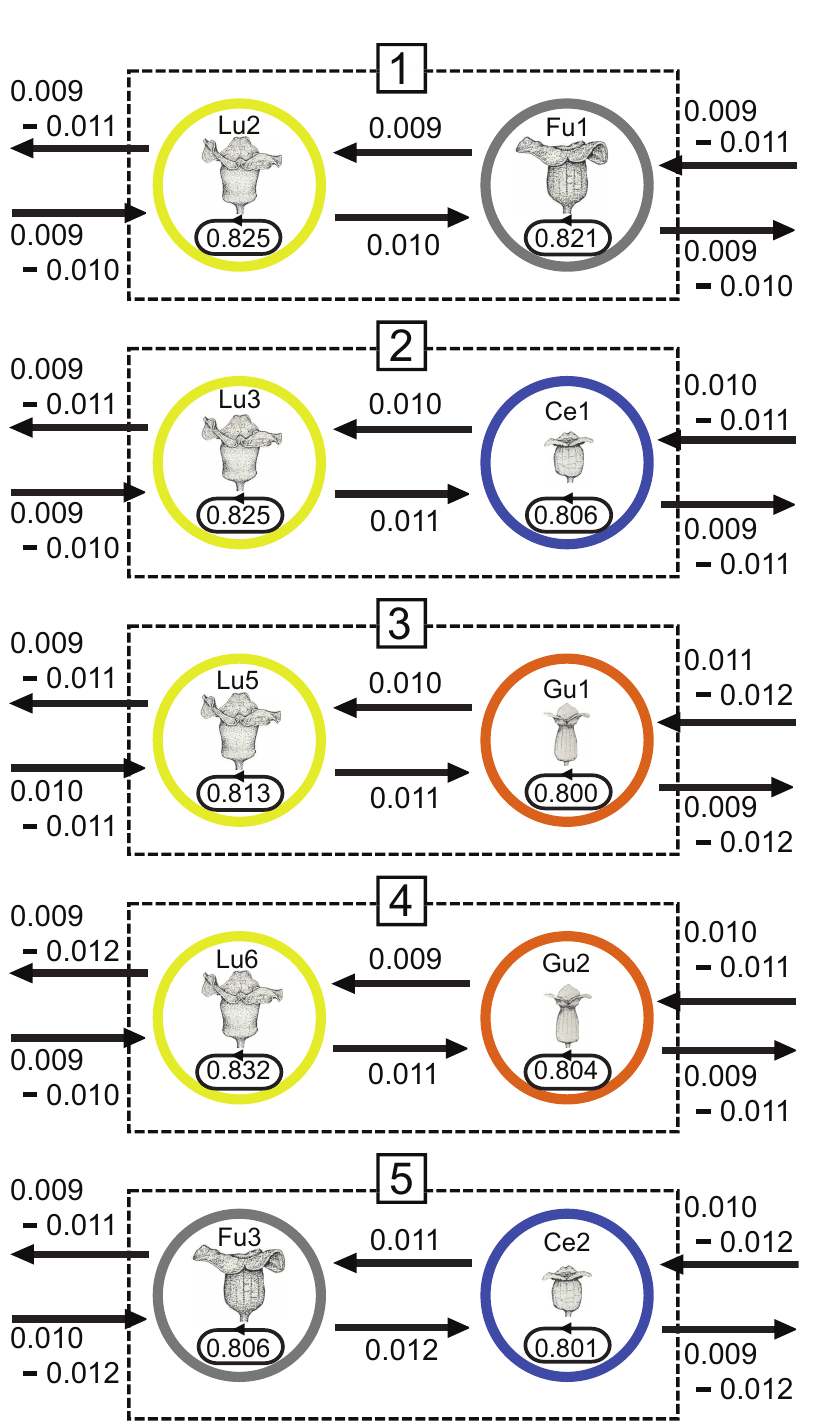
Fig 6. Mean values for the posterior distribution of the migration rate ( m ) of each Asarum populations within “sympatricstands” on Amami Oshima estimated using BayesAss. Estimated migrationrates are shown betweenspecies in “sympatric stands” 1–5, each of which containstwo species. The estimates for “sympatric stands” 1 – 4 were based on data for the nine core loci whilethose for “sympatric stands” 5 were basedon data for the full set of 12 loci. The stand and population abbreviationscorrespond to those used in Fig 1, S3 Table, S4 Table and S5